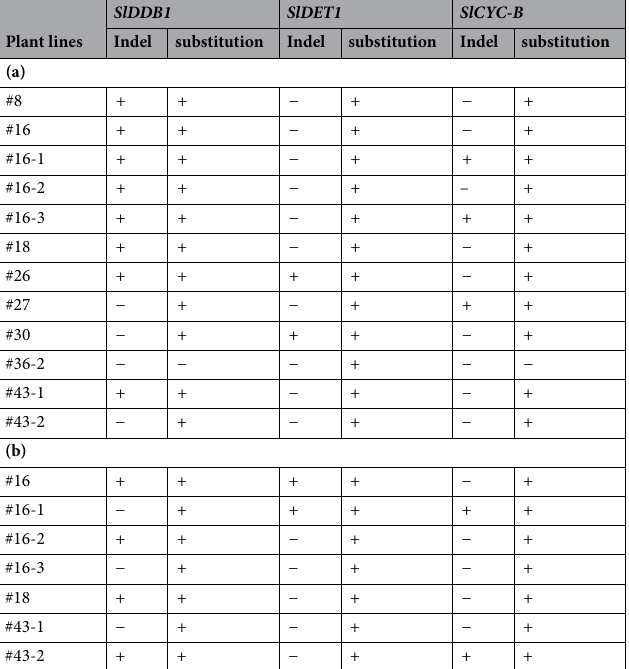
Table 2. Mutation type obtained in T 0 and T 1 generations of edited tomato lines. (a) Mutation type observed in all T 0 diploid plants obtained and (b) in all T 1 segregated lines. For each target, the presence or absence of sub mentioned type of mutation is indicated with a ‘+’ for presence or ‘−’ for absence,